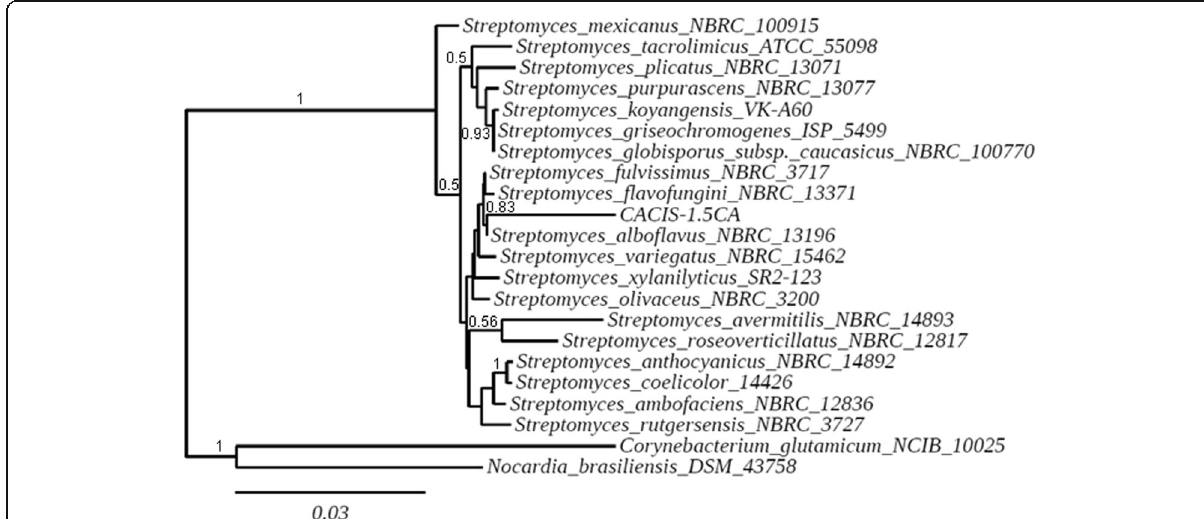
Fig. 2 Phylogenetic relationship among Streptomyces sp. CACIS-1.5CA and other Streptomyces species. The numbers at the nodes representing